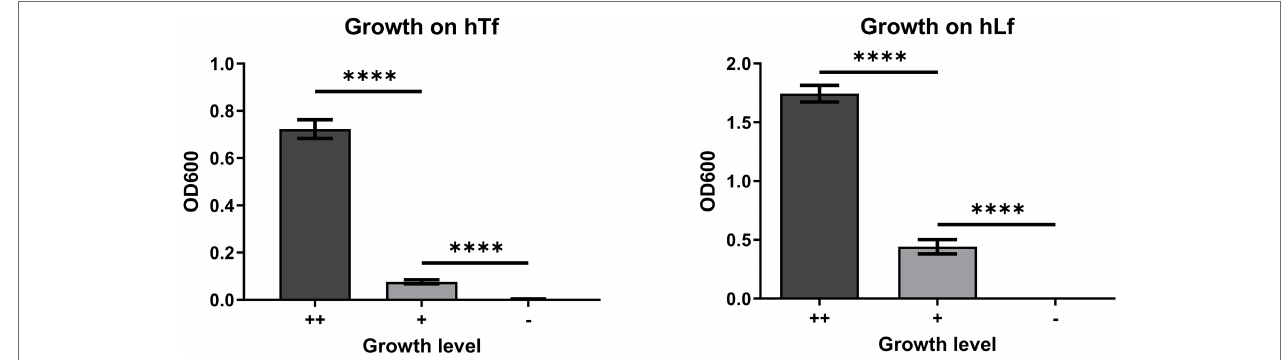
FIGURE 2 | OD600 of resuspended cells from the bacterial growth on human transferrin (hTf) and human lactoferrin (hLf) in the plate-based feeding assay. ++, denotes wild type growth level; +, denotes less than wild type growth level; − , denotes no growth. The hTf experiment was performed using strains N148, N494, and N149; the hLf experiment was performed using strains N148, N149, and N488. Results are presented as mean ± SEM. Each bar represents six replicates. ****Denotes p < 0.0001.